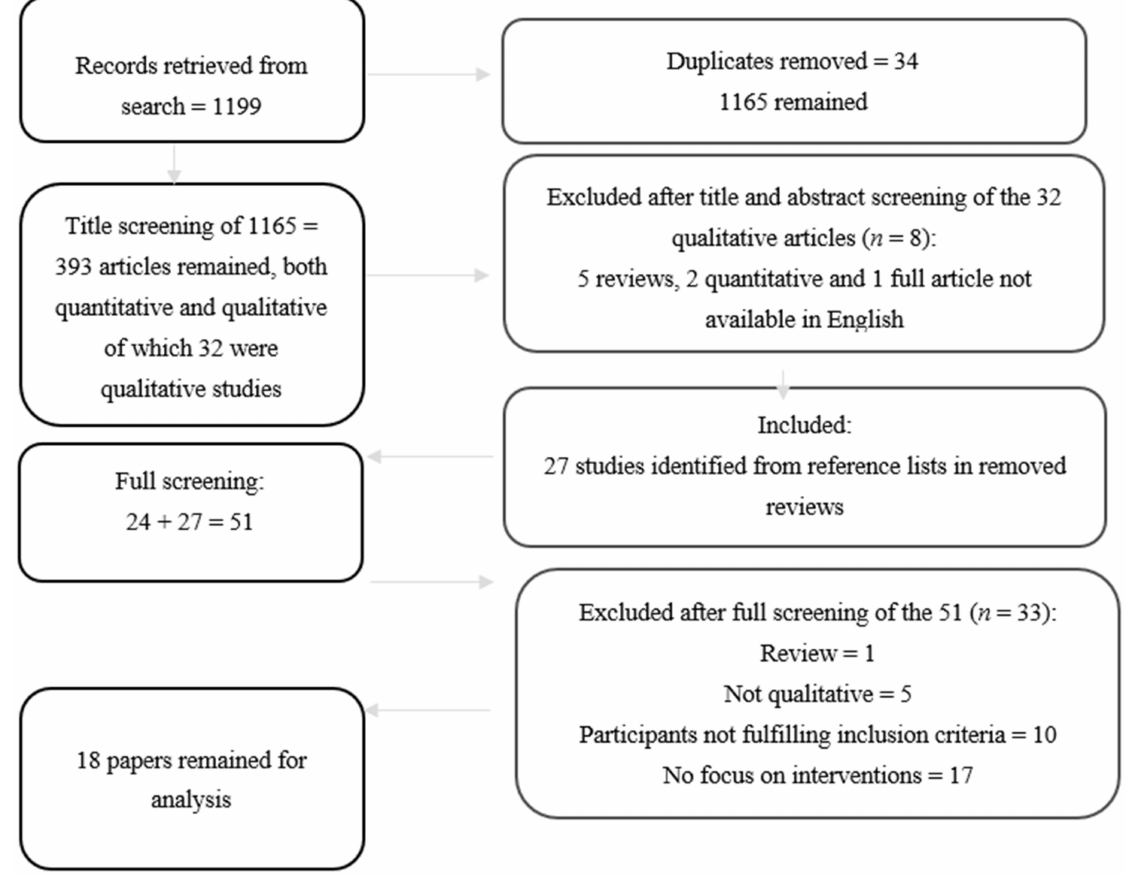
Figure 1. Flowchart of the search and study selection